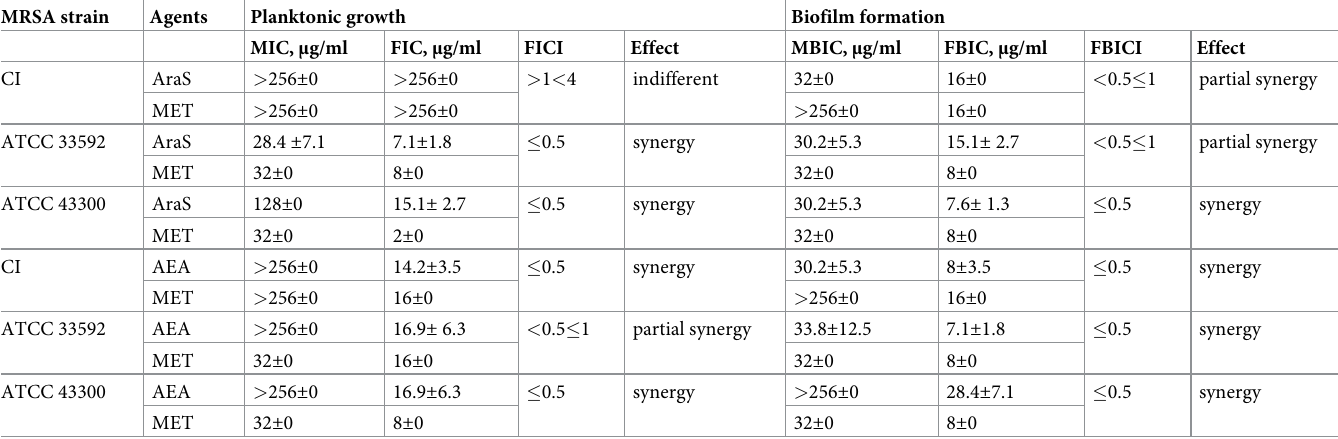
Table 3. Effects of the combinations of AraS/AEA with MET against MRSA